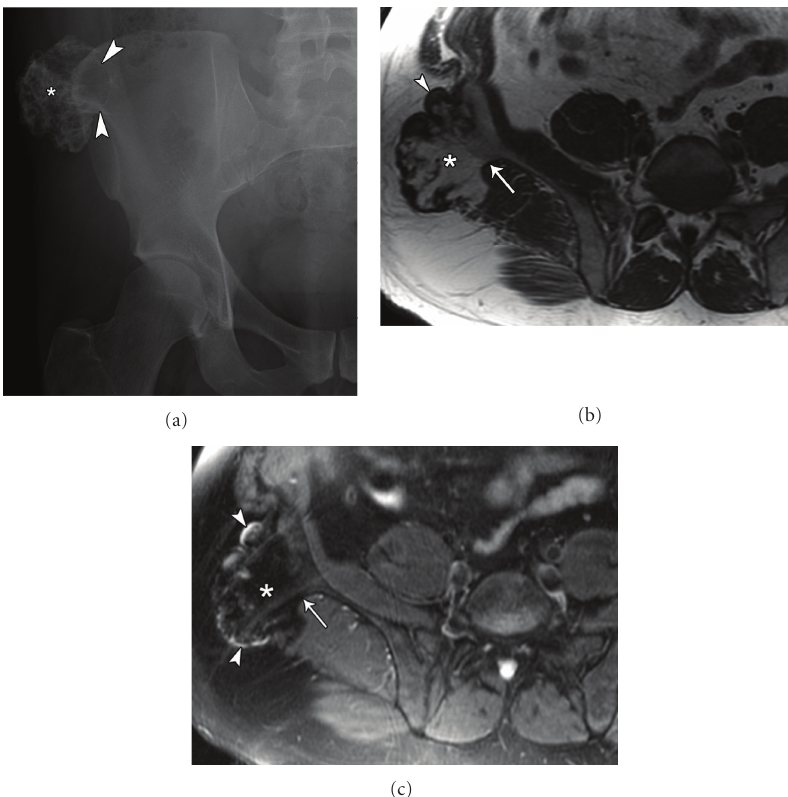
Figure 2: 31-year-old male presents with palpable hard mass lateral to right iliac crest diagnosed as an osteochondroma. Pelvic plain film (a) demonstrates an irregularly calcified, pedunculated lesion (asterisk) arising from the right iliac crest. It presents as a peripheral outgrowth with its cortex in continuity with the iliac bone (arrowheads). Axial T1 (b) and axial T2 fat sat. (c) MRI images of same lesion (asterisk) demonstrate the continuity of the cortex and medullary portion of the lesion with the parent bone (arrow) and identify a thin cartilage cap